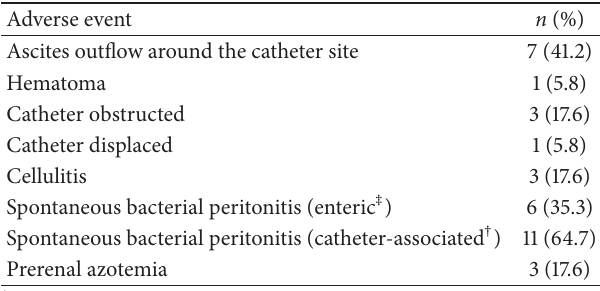
Table 2: Adverse events following PleurX catheter insertion ( 𝑁 = 17 ).